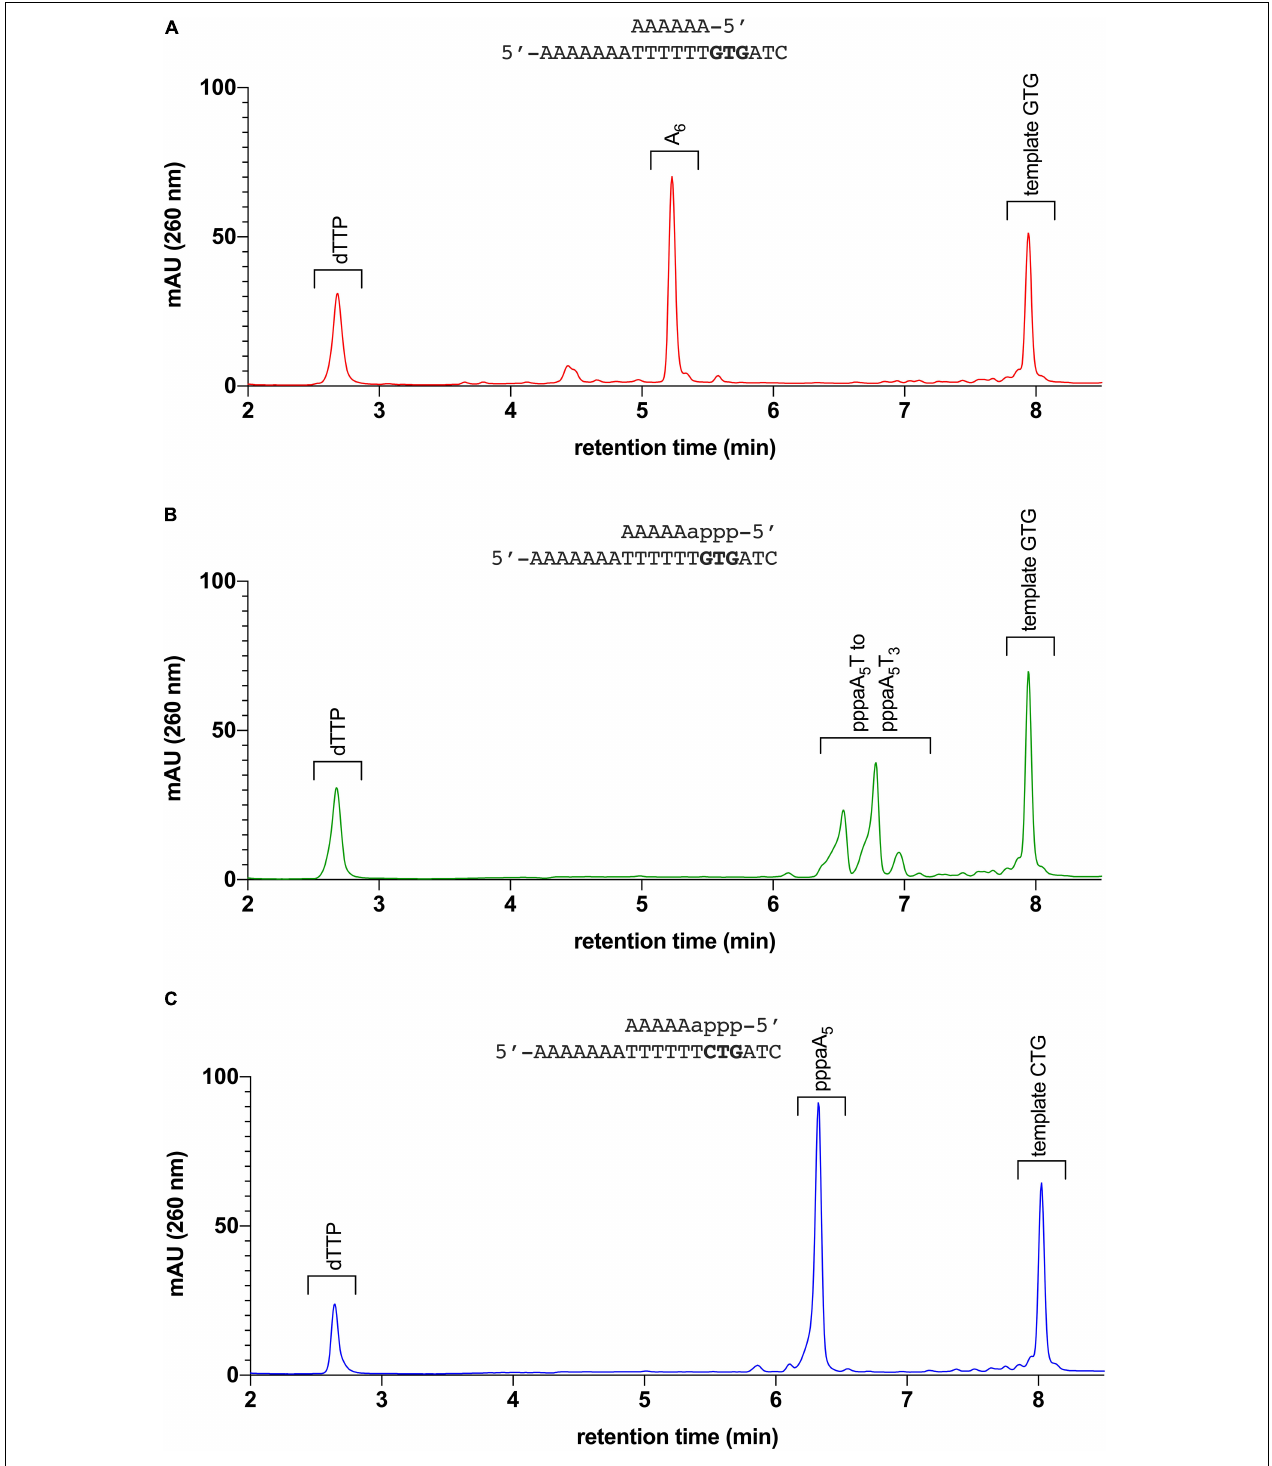
FIGURE 2 | Elongation assay: pRN1 enzyme incubated with different primer-template substrates. (A) Primer-template combination A6/GTG: The synthetic 6 nt primer is not elongated by the primase in presence of dTTP. (B) Primer-template combination pppaA5/GTG (6 nt primer with triphosphorylated ribonucleoside at 5 (cid:48) terminus): The 6 nt primer is elongated by the primase in presence of dTTP. Incorporation of dTTP by the primase leads to formation of unit length products (primase mode, for comparison of primers formed with this template, refer to Supplementary Figure 1 ). (C) Primer-template combination pppaA5/CTG: The primer pppaA5 on a template lacking the recognition sequence GTG is not elongated. No unit length products are observed with template CTG instead of GTG.